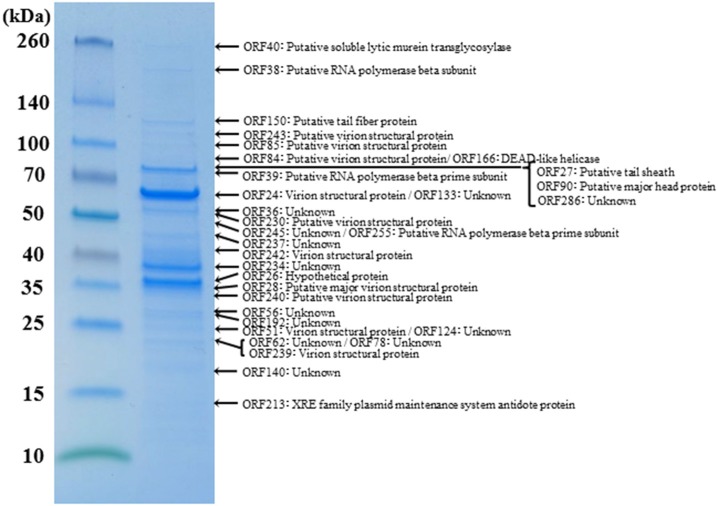
Proteomic analysis of virion proteins of ΦRP31. Proteins from purified ΦRP31 particles were separated by SDS-PAGE and stained with Coomassie blue. The protein bands excised from the SDS-PAGE gel were subjected to trypsin digestion and analysis by liquid chromatography-tandem mass spectrometry (LC-MS/MS, LTQ Orbitrap XL). Tandem mass spectrometry data were assigned to tryptic peptides encoded by phage open reading frames using an established procedure (Ahmad et al., 2014). Asterisks indicate the fragmented β and β′ subunits of virion-associated-RNAP. VSP: virion structural protein.